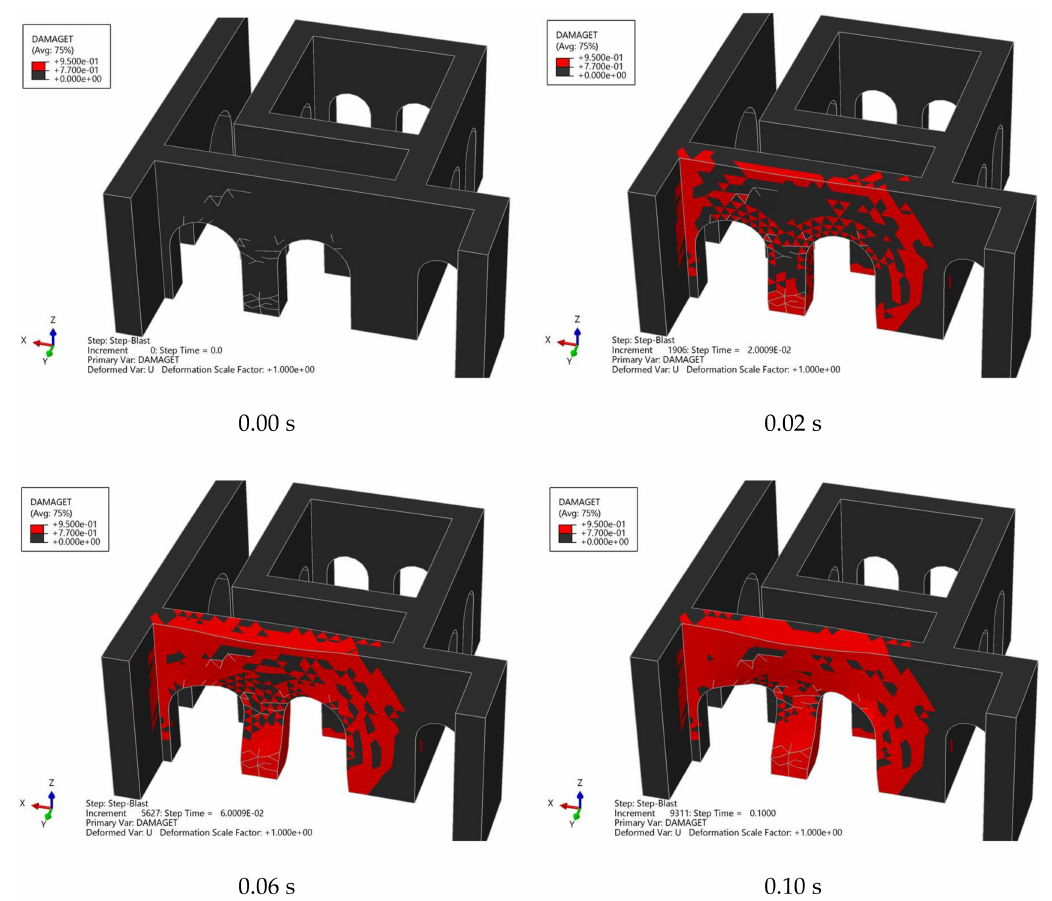
Figure 9. Time history of the damage to the interior walls of the building. The wall Z1-S was modeled on its own to better understand the effect of the mesh size on the damage. Boundary conditions on this wall were selected so that the deformed shape of the wall matched the wall in the previous analysis. This wall was modeled using three different element sizes (0.1 m, 0.2 m, and 0.3 m) to understand if this impacted the damage in the wall. Figure 10 shows the displacement in all three walls occurring at a time of 0.06 s. In all three scenarios, the largest displacement occurs between the central and far-right arches, but the magnitude of the displacement is largest in the walls with a smaller mesh size. This difference in displacement directly affects the magnitude of the rotation at the center of the wall.